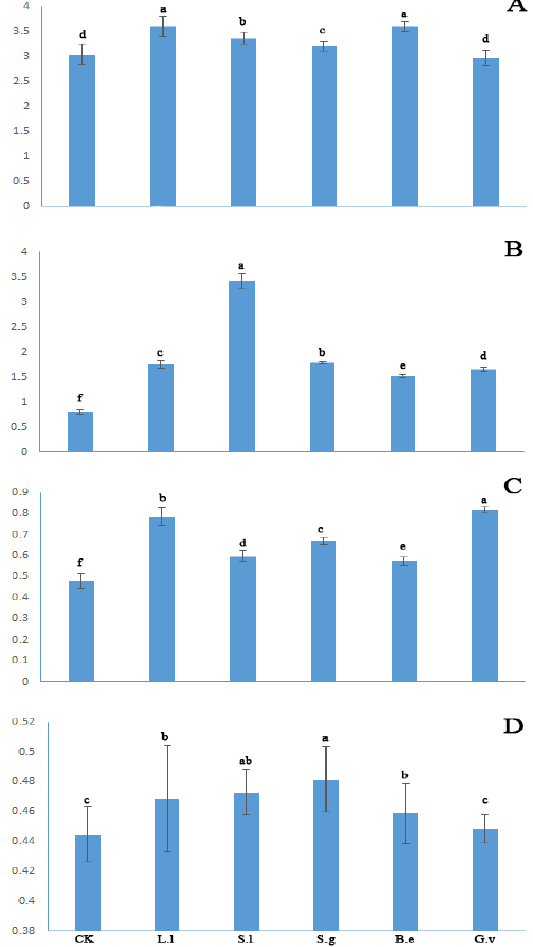
Figure 4. Enzymatic activity in the rhizospheric soil of P. tabulaeformis seedlings inoculated with L. laccata (L.l), S. luteus (S.l), S. grevillei (S.g), B. edulis (B.e), G. viscidus (G.v), and treated with sterilized substance (CK). The letters denote: ( A ) catalase activity, (0.1 mol/L KMnO 4 mL/g soil); ( B ) urease activity, (NH 3 ‐ N mg/g); ( C ) phosphatase activity, (phenol mg/g); and ( D ) protease activity, (amino ‐ nitrogen g/100 g). The error bars refer to standard deviation.